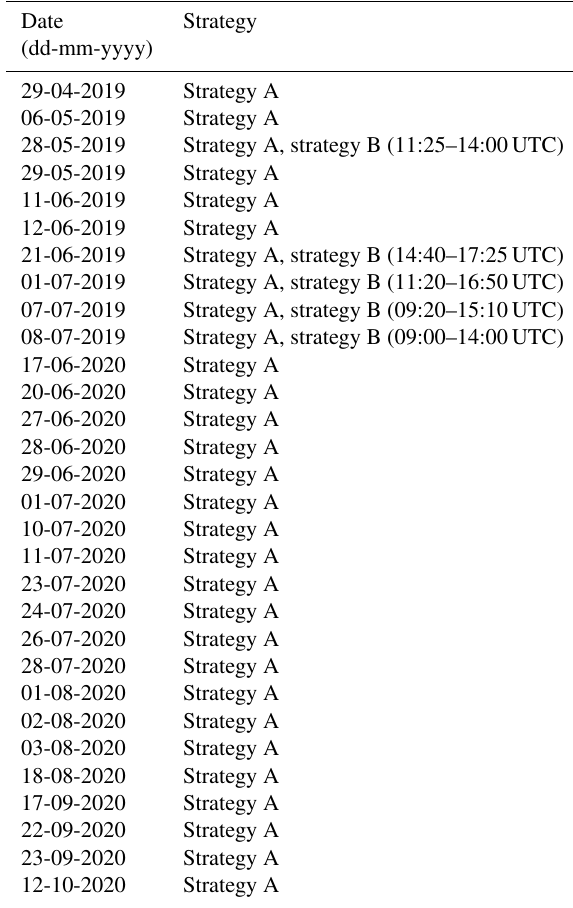
Table A1. List of convective days that were used in our analyses. Strategy A always refers to the whole